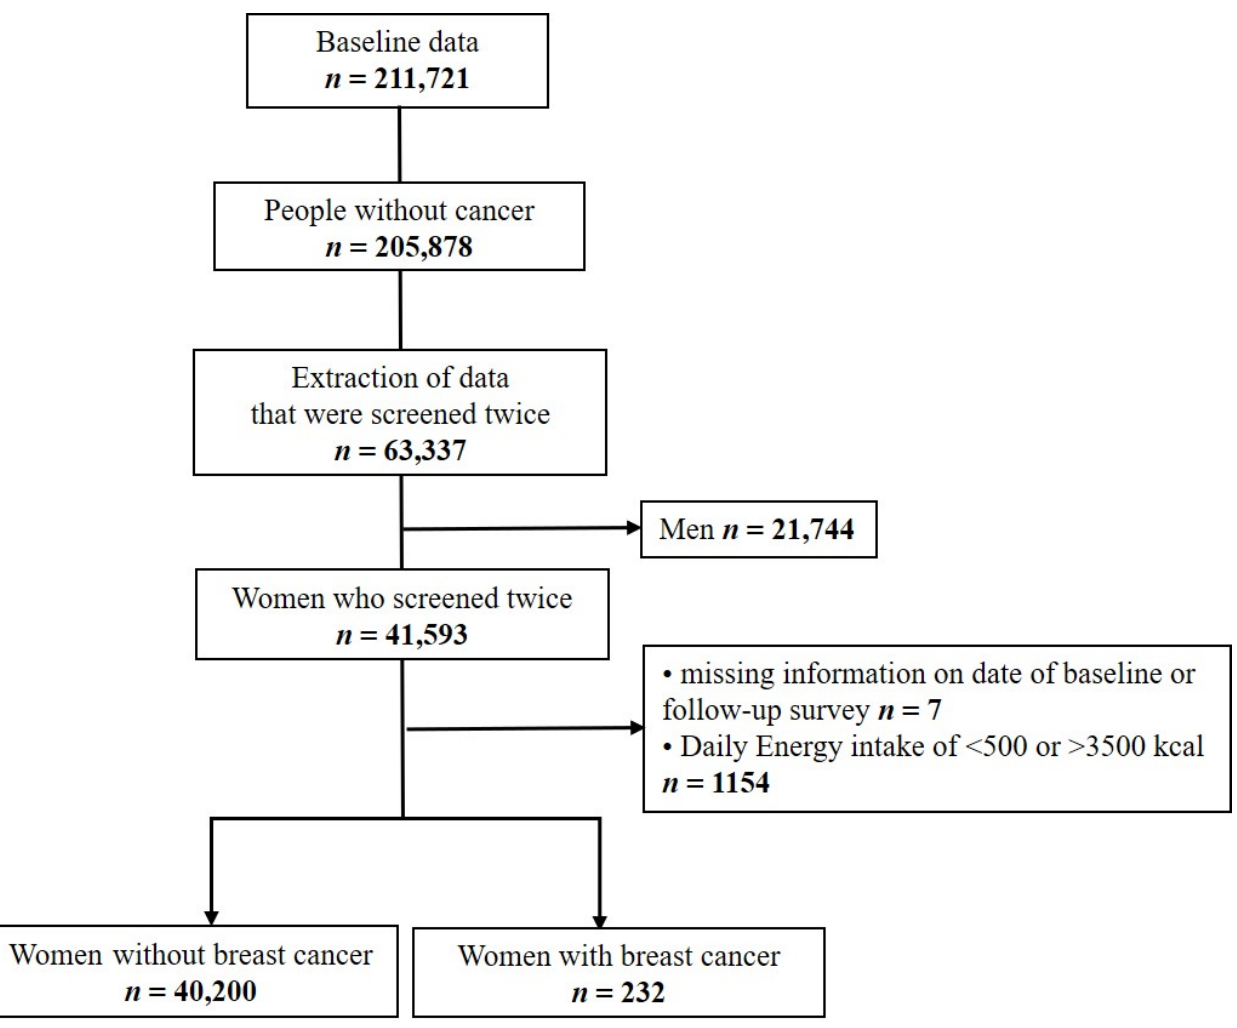
Figure 1. Flow chart for the participant selection protocol.